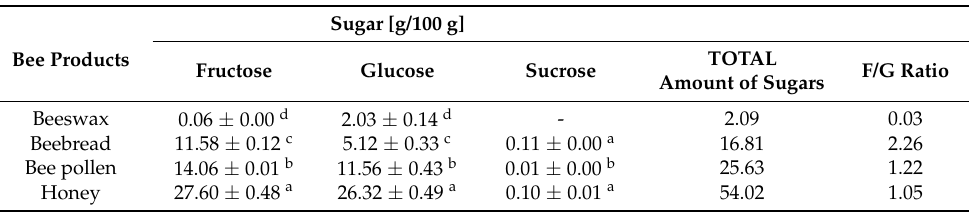
Table 2. The content of sugars (fructose, glucose, and sucrose at the level of g/100 g), total amount of sugars, and fructose/glucose ratio (F/G) determined in bee